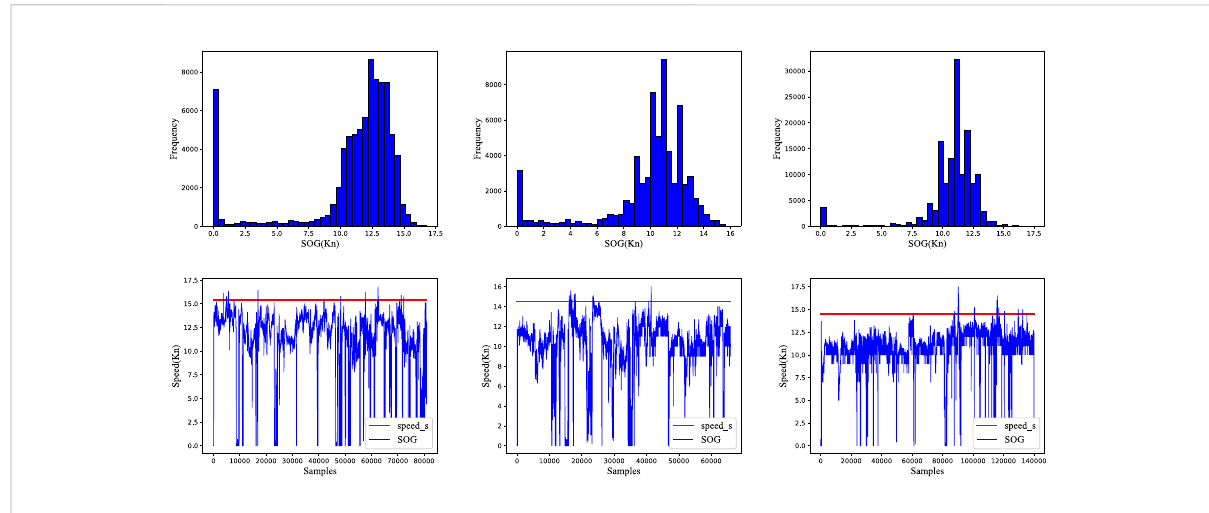
FIGURE 4 SOGnumericaldistribution.TheupperthreesubgraphsaretheSOGnumericaldistributionhistograms. ThelowerthreesubgraphsaretheSOG numerical line charts, in which the red horizontal line is the designed service speed of the